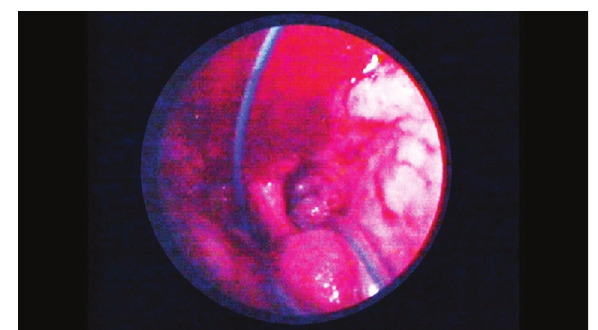
Endoscopic view of adenoid bed